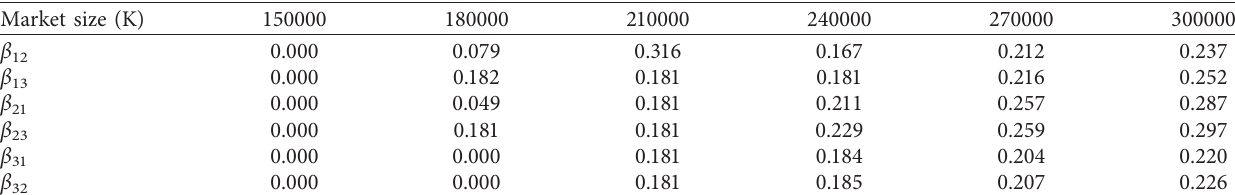
Table 7: Balanced point of symbiotic